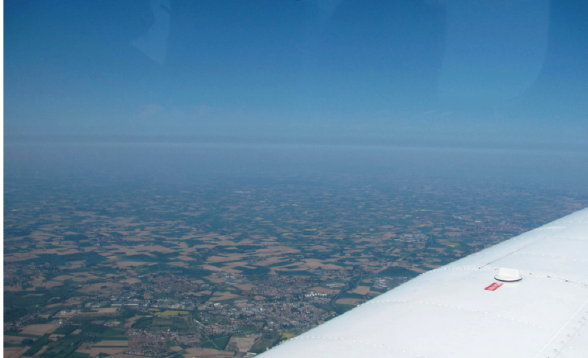
Fig. 9. Volcanic ash layer (grey layer in the horizon direction) at around 2.5km altitude and close to Lille city, 19 May 2010 (cour- tesy from Y. Karol and C. Verwaerde,